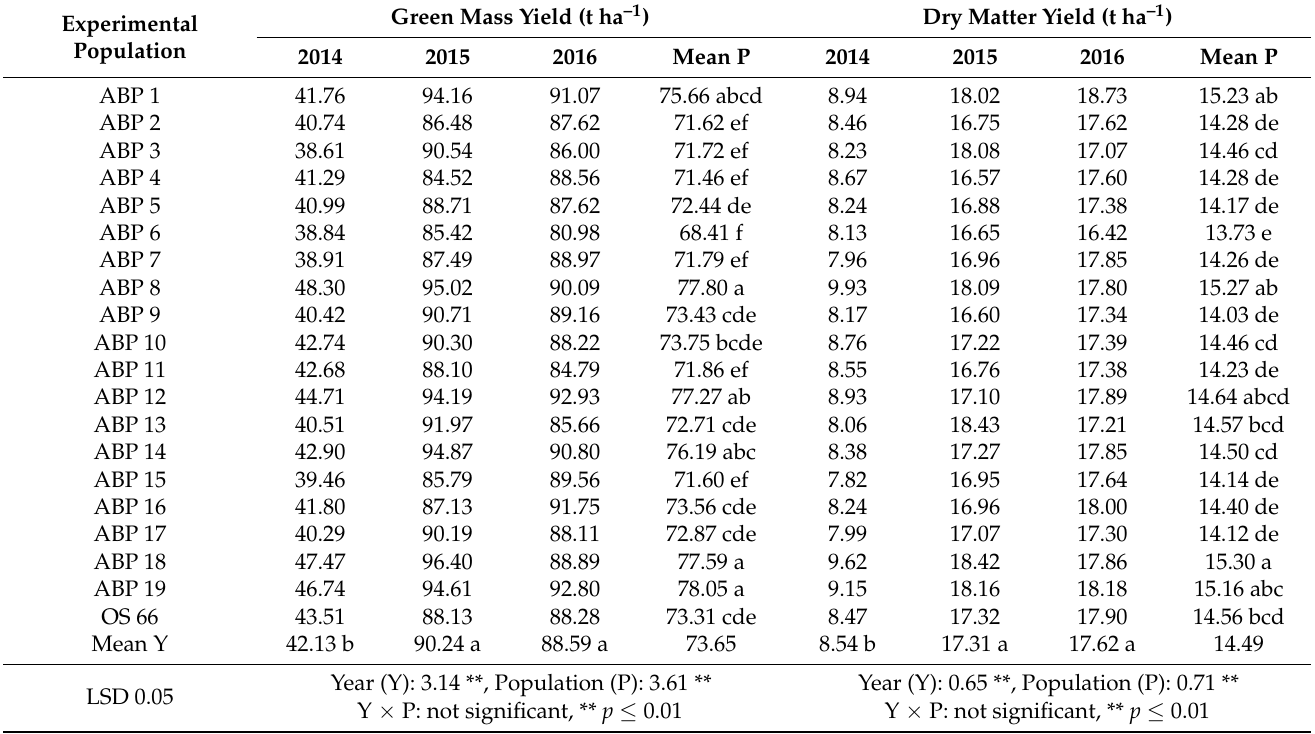
Table 2. Green mass and dry matter yields (t ha –1 ) of alfalfa experimental populations/cultivar during